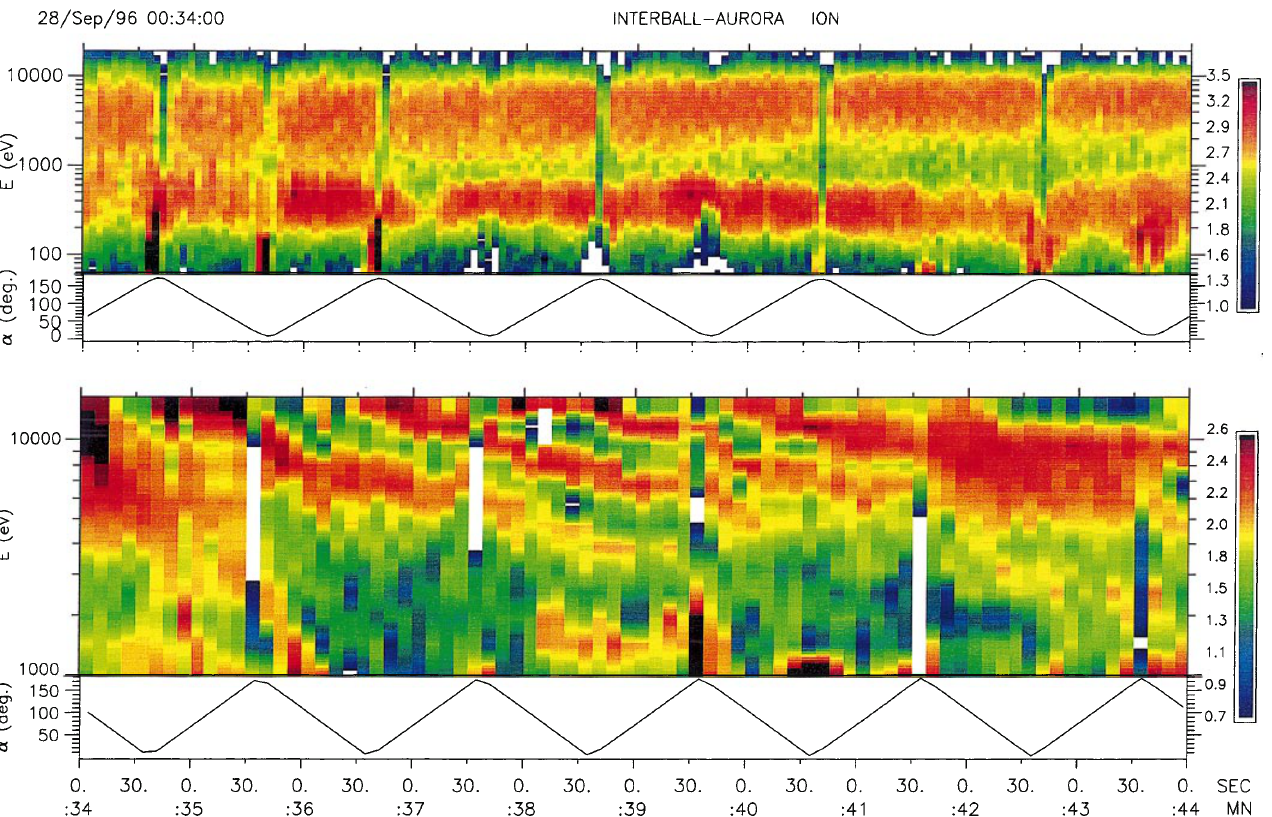
Fig. 11. Detail of Fig. 10 between 00:34 and 00:44 UT on 28 September 1996. Note the ion energy-time dispersions with the simultaneous detection of plasma sheet electrons ( E > 1